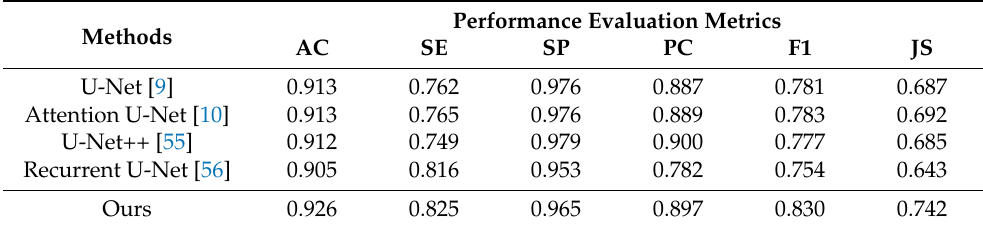
Table 3. Performance comparison between the proposed network and other methods on the ISIC-2017 dataset. Methods